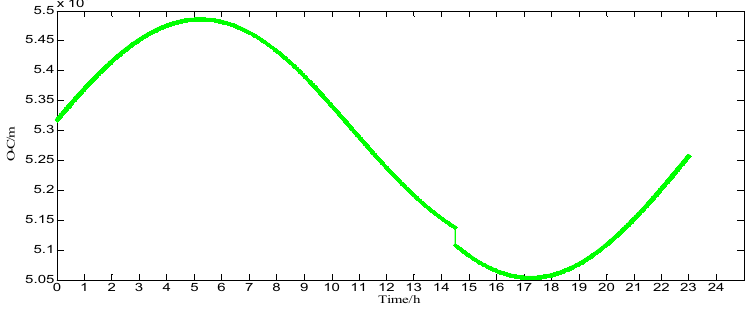
Figure 9. Results of O-C of GEO-03 at WUH1.